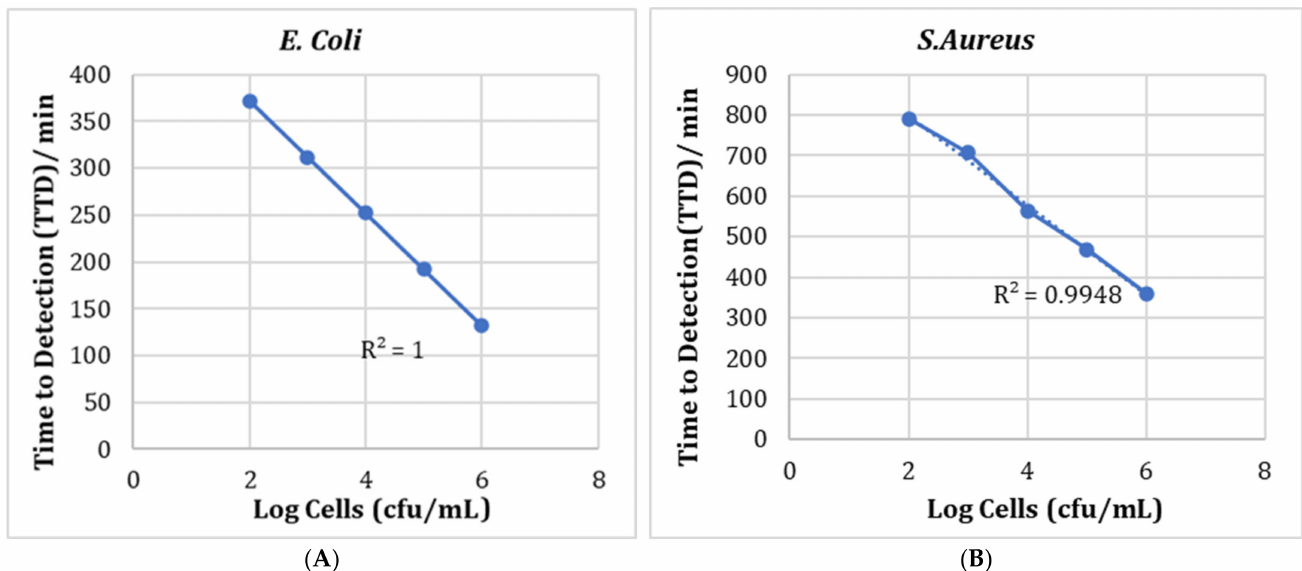
Figure 9. Calibration curves for E. coli ( A ) and S. aureus ( B ) with detection limit at Abs600 = 0.2. Testing with Chitosan